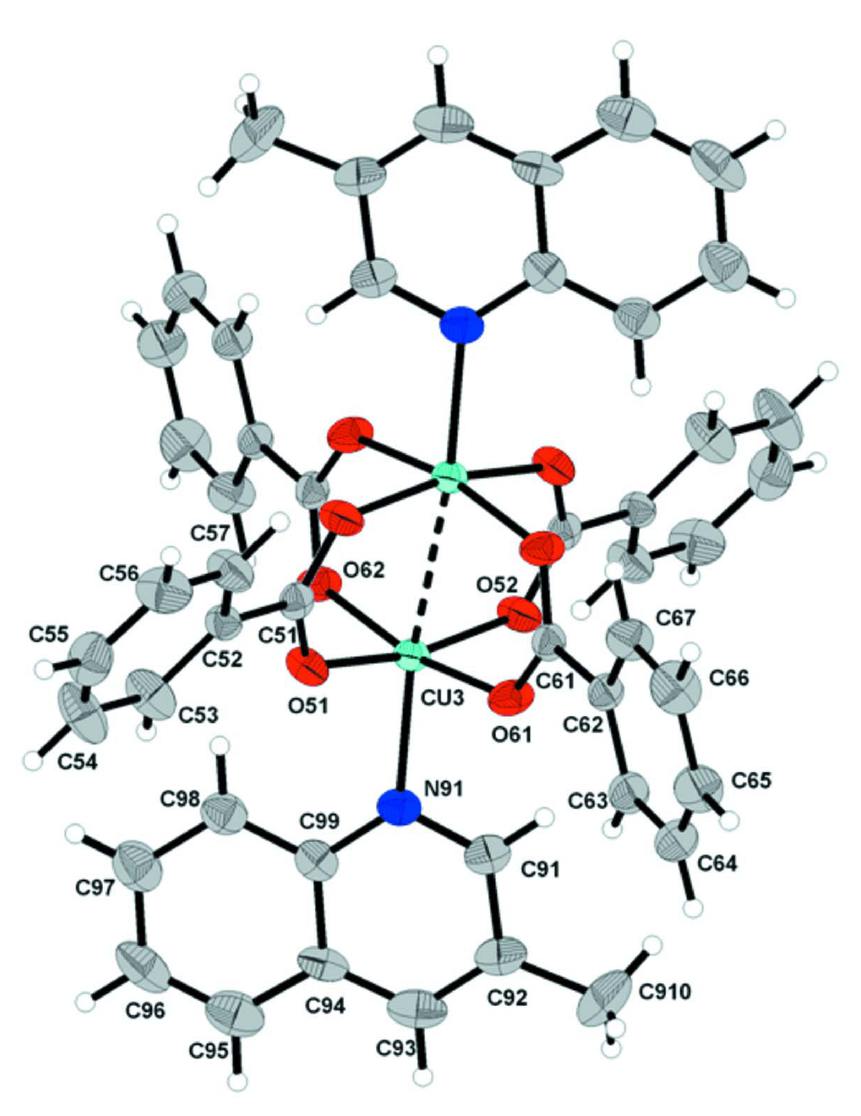
The molecular structure of the other indpendent moleclue of the title compound showing the atom-labeling scheme. Displacement ellipsoids are shown at the 30% probability level. Unlabeled atoms are related by the symmetry operator (- x + 1,- y + 1,- z +